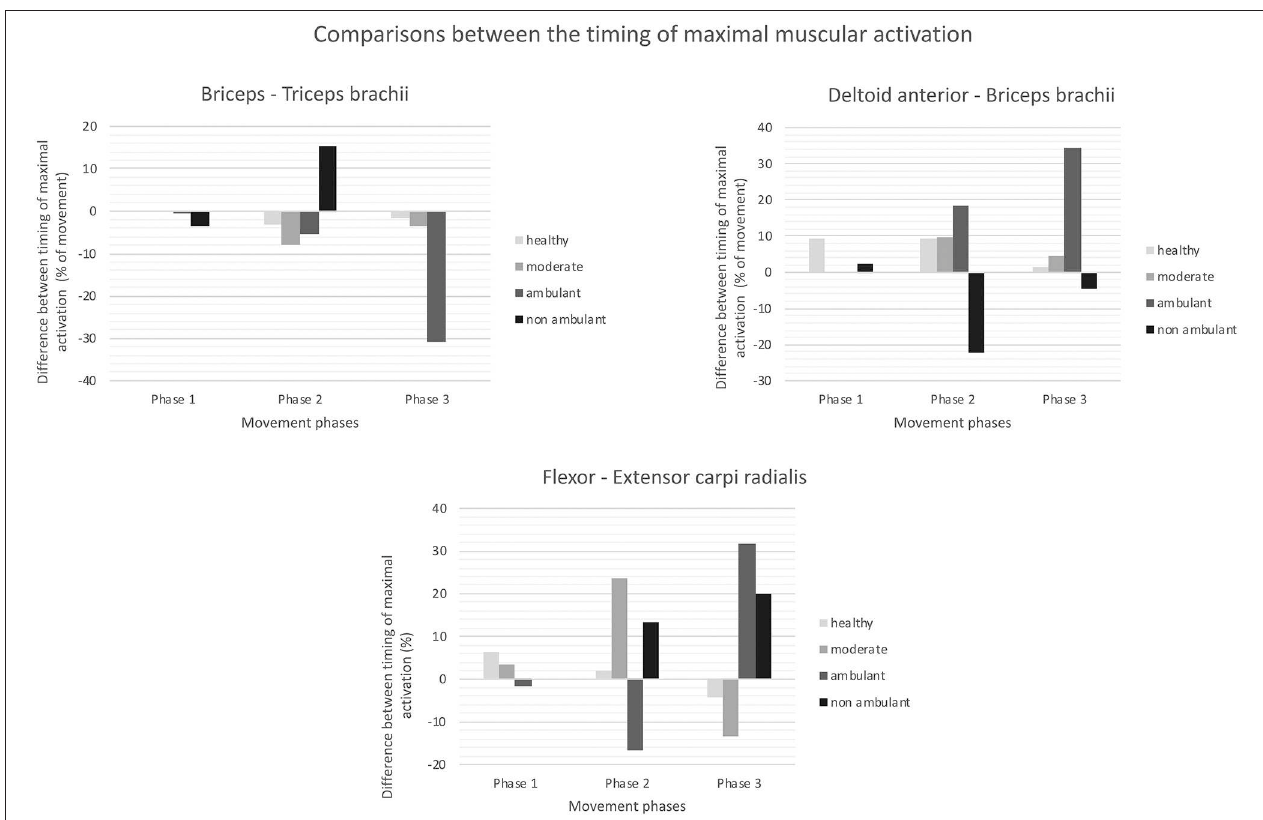
FIGURE 4 | Difference between the timing of maximal activation for functionally coupled